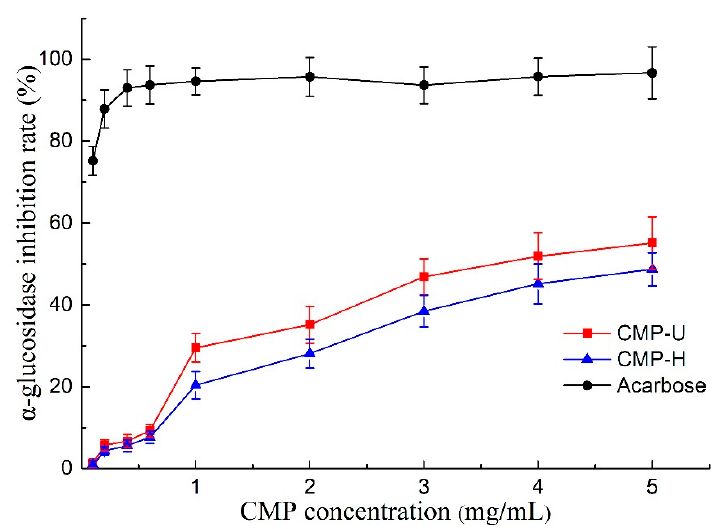
Figure 7. α -glucosidase inhibitory effect of CMP-U and CMP-H. CMP-H: C. morifolium polysaccharides obtained by hot reflux extraction; CMP-U: C. morifolium polysaccharides obtained by ultrasonic assisted extraction.